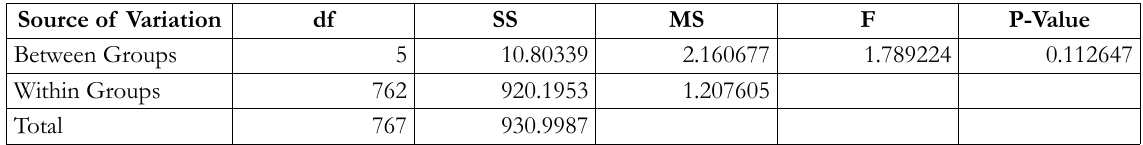
Table 24. Anova Table for Support Service